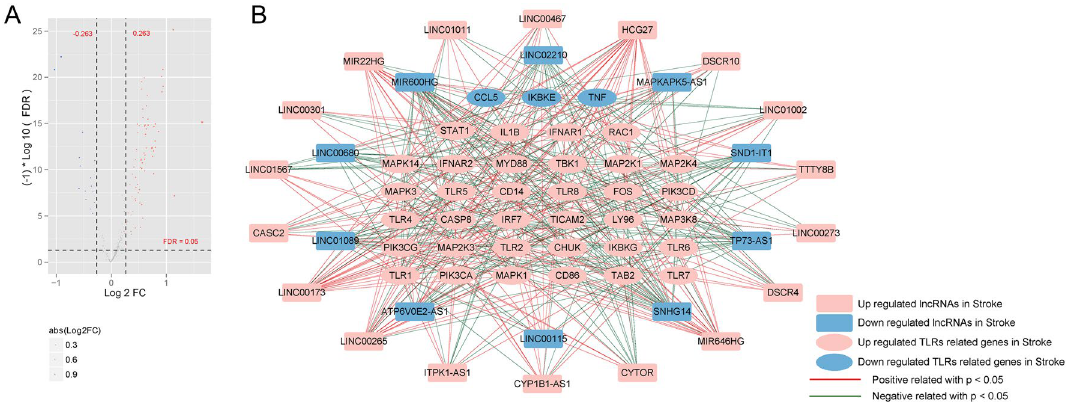
Figure 1. Identification of the DEGs associated with TLR signaling pathway and DElncRNAs ( A ) and their co-expression network ( B